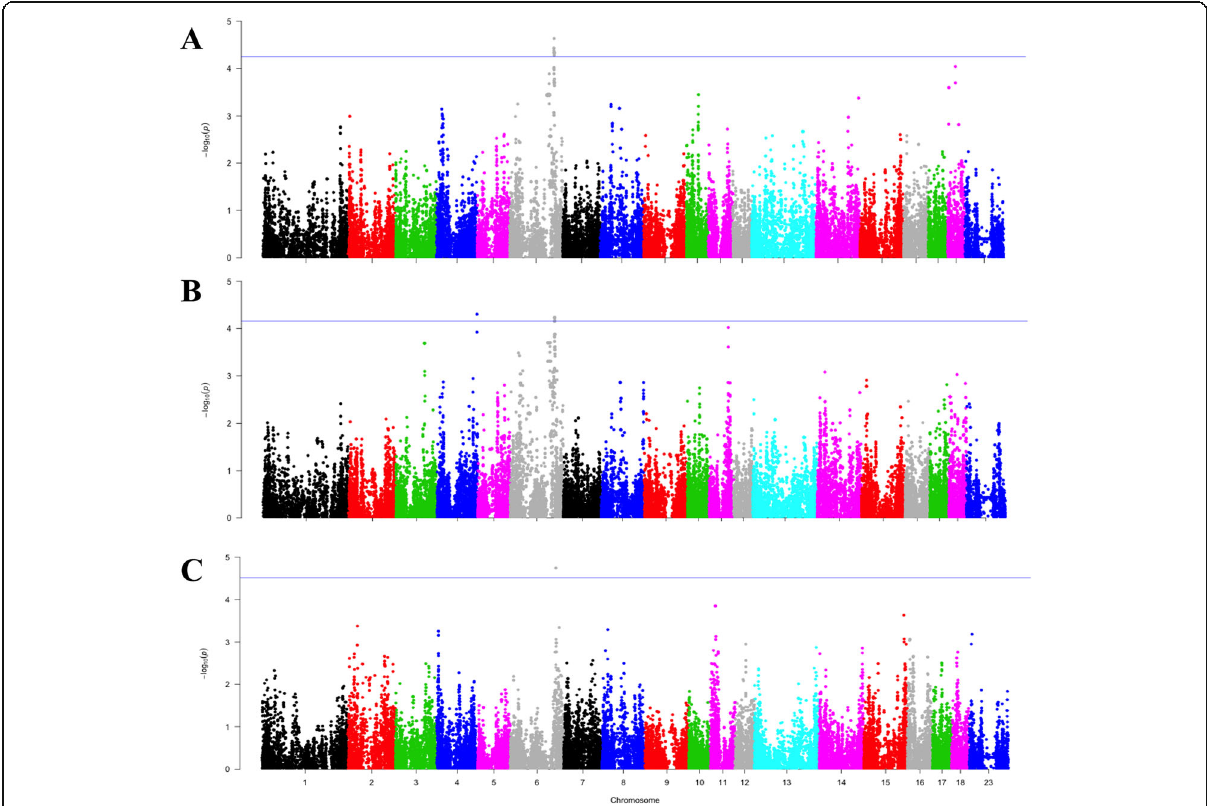
Fig. 2 Significance across the whole genome of the association between SNP markers and the relative abundance of ( a ) Blastocystis sp. ATCC 50177, ( b ) Blastocystis sp. CK8166 and ( c ) Fungi Alpha diversity. The x-axis represents the pig autosomal chromosomes (1 – 18), and the y-axis the significance level represented as the – log 10 ( P